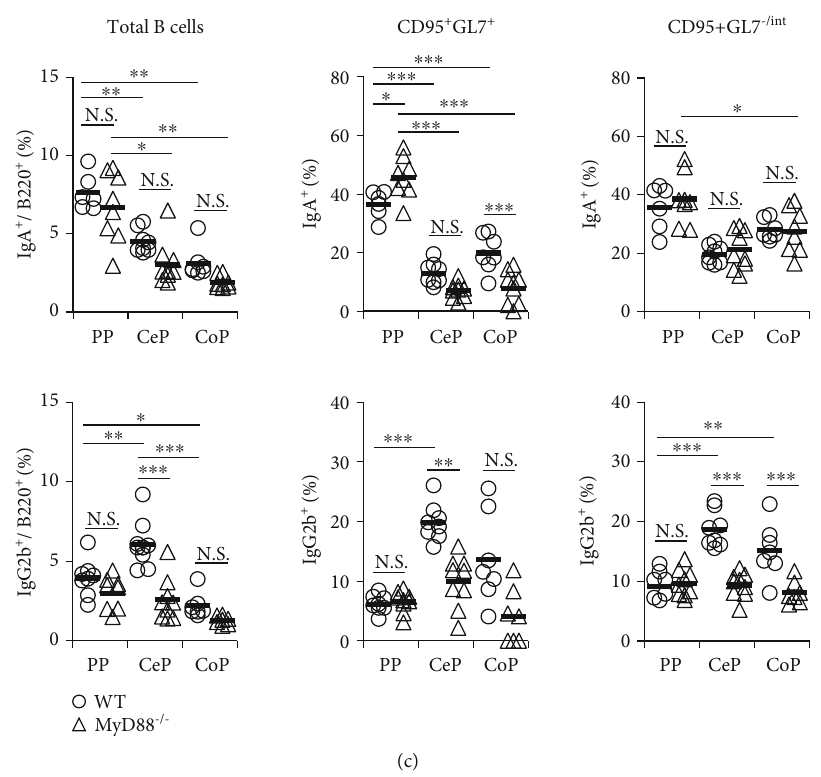
Figure 3: The role of MyD88 signaling in GC formation and antibody expression on B cells in GALT from the small and large intestines. Flow cytometric analysis of the mononuclear cells of each GALT from SPF WT and MyD88 -/- mice was performed. (a) Left panel: fl ow cytometric dot plot of CD95 and GL7 expression in B220 + cells. Right panel: percentage and absolute numbers of CD95 + GL7 + B220 + GC B cells and CD95 + GL7 -/int B220 + pre-GC B cells. (b) Left panel: fl ow cytometric dot plot of CXCR5 and PD-1 expression in CD4 + CD3 + cells. Right panel: percentage and absolute numbers of CXCR5 + PD-1 + CD4 + CD3 + Tfh cells. (c) The percentage of B220 + total B cells, CD95 + GL7 + B220 + GC B cells, and CD95 + GL7 -/int B220 + pre-GC B cells expressing IgA or IgG2b. Data are shown as mean ± SD and are representative of the fl ow cytometric dot plot from seven to eight independent experiments. ∗ p < 0 : 05 , ∗∗ p < 0 : 01 , and ∗∗∗ p < 0 : 001